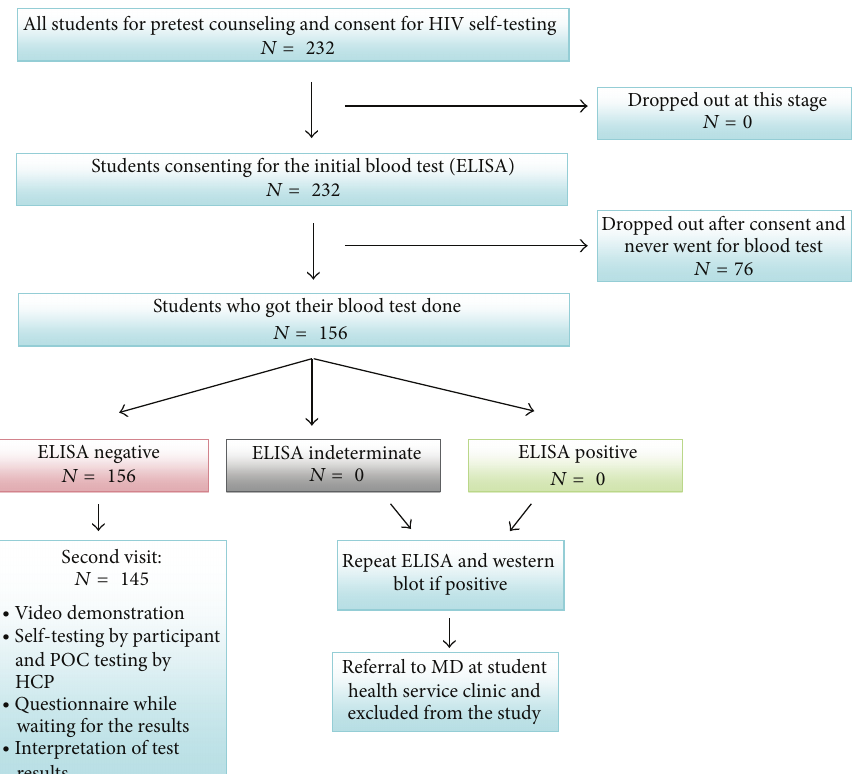
Figure 1: Flow of participants and test